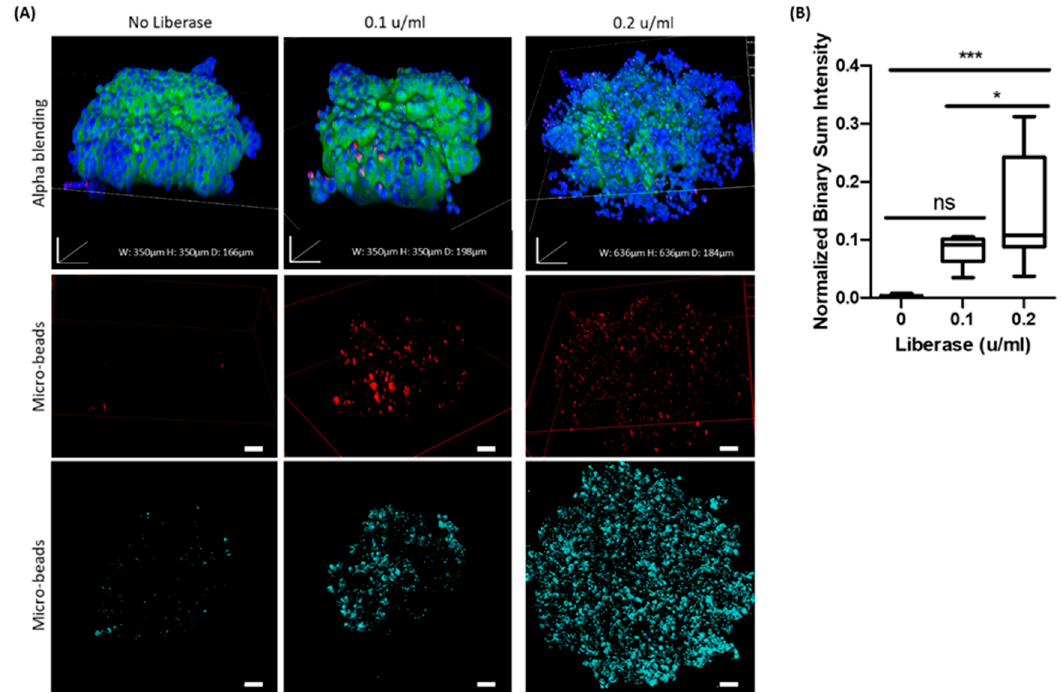
Figure 7. The effect of extracellular matrix “relaxation” of AsPC-1 spheroids as an ex vivo tumor model on particle diffusion. The penetration of 0.8 µm fluorescent purple microparticles into AsPC-1 spheroids treated with Liberase (0.1 or 0.2 of Wunsch units/mL) was compared with untreated spheroids. Spheroids were incubated with the particles (red) for 24 h and stained with DAPI (blue) and Coumarin-6 (green). ( A ) Alpha blending mode represents 3D stacking and reconstitution into a whole spheroid. Labeled particles demonstrated both adhesion and penetration into the spheroids’ inner layers, depending on the concentration of the enzymatic treatment. Internal optical sections demonstrated the presence of particles in the depth of the spheroid (80 µm). The red color of the particles observed in this figure was converted to light blue to increase contrast for visualization purposes. Scale bar = 50 µ m. ( B ) The graph represents the quantification of 0.8 µm particles that penetrated the spheroids with or without Liberase treatment, n = 5, * p < 0.03, *** p < 0.0006, ns, not significant.